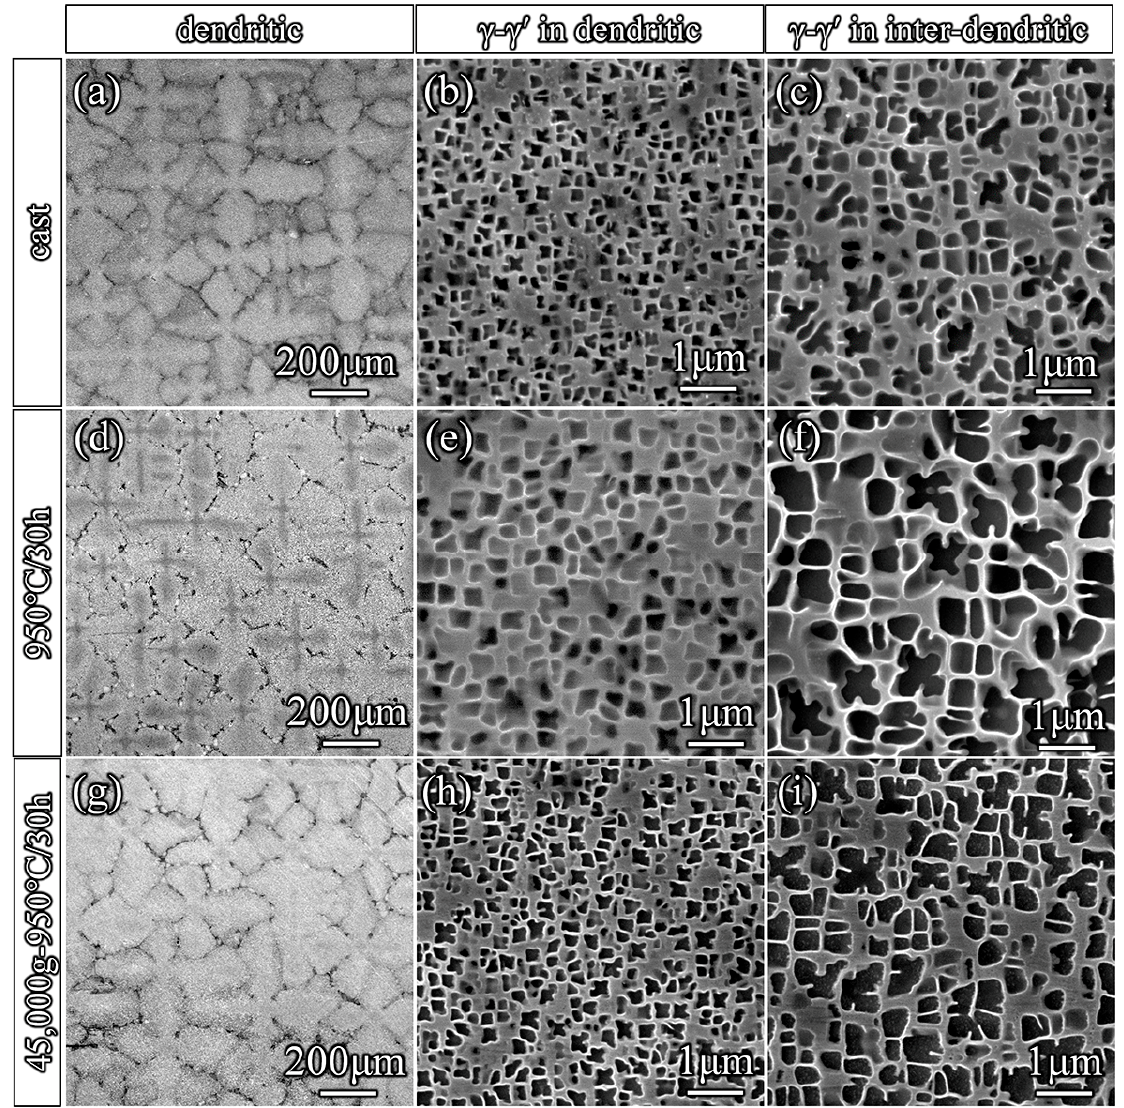
Figure 5. Comparison of the microstructures in the cast, aging and super-gravity treatment specimens. ( a – c ) Cast specimen. ( d – f ) Aging treatment specimen. ( g – i ) Super-gravity treatment specimen.